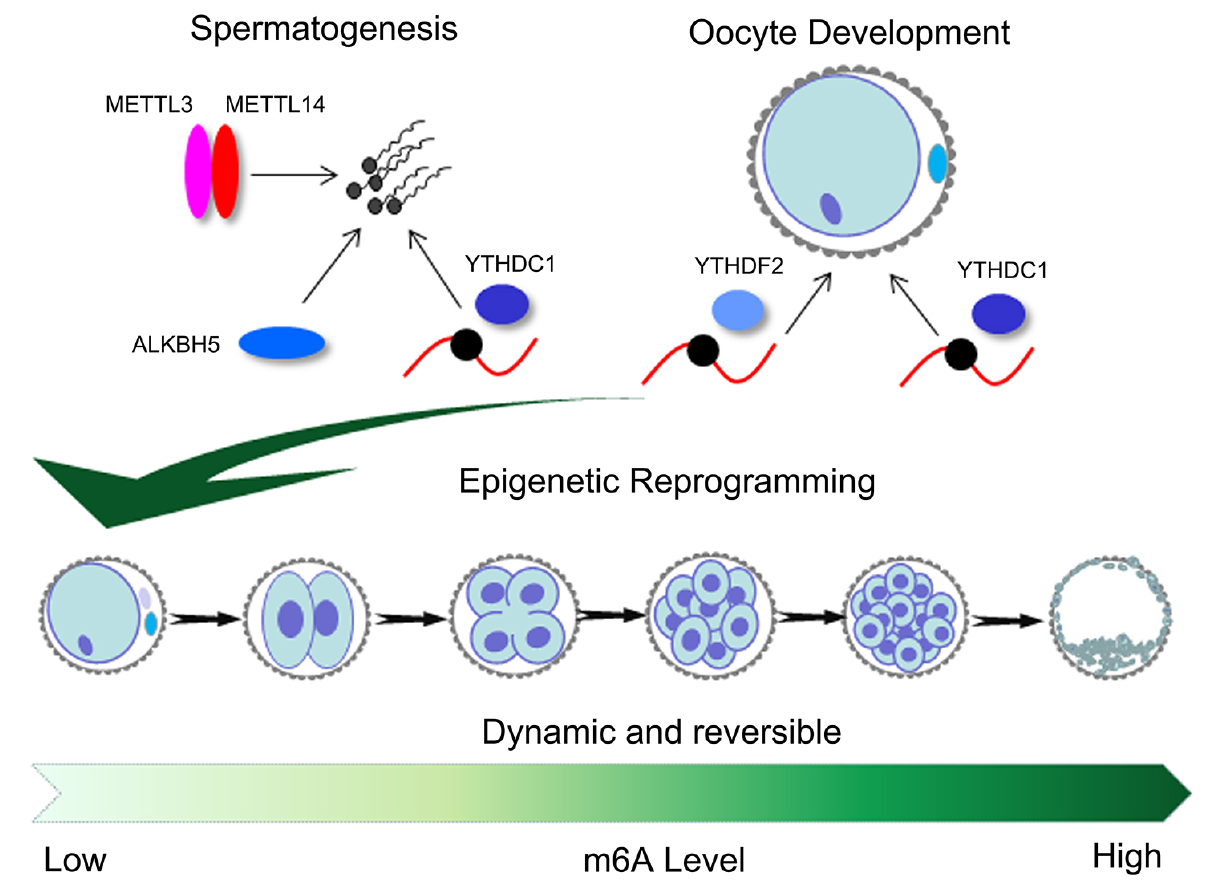
Figure 3 – Modification of m6A in embryonic epigenetic reprogramming. METTL3/METTL14, YTHDC1, and ALKBH5 play important roles in spermatogenesis. YTHDC1 and YTHDF2 are crucial in oocyte development. The dynamic and reversible m6A modification processes establish epigenetic reprogramming after fertilization. m6A levels increase during embryonic